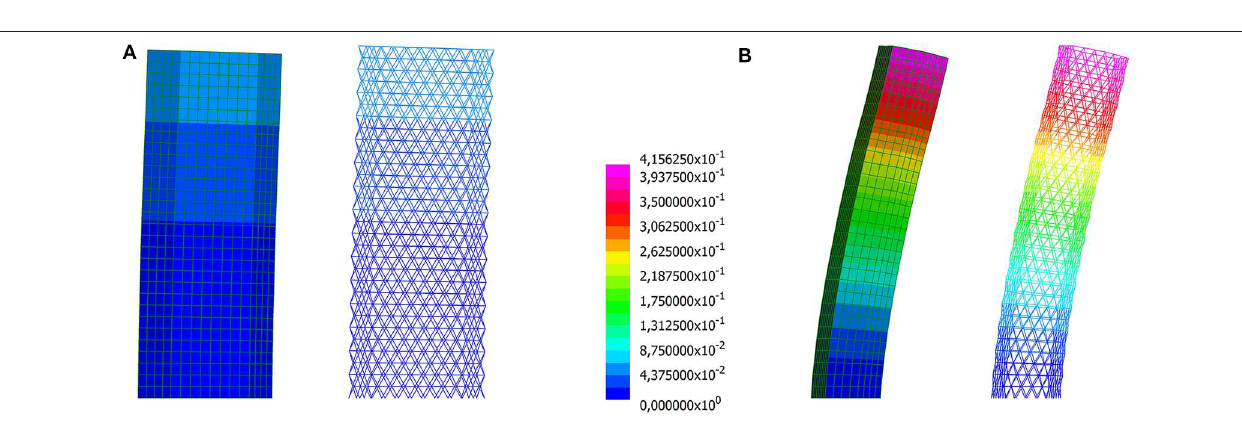
2 elements, W 89,507kN. × =